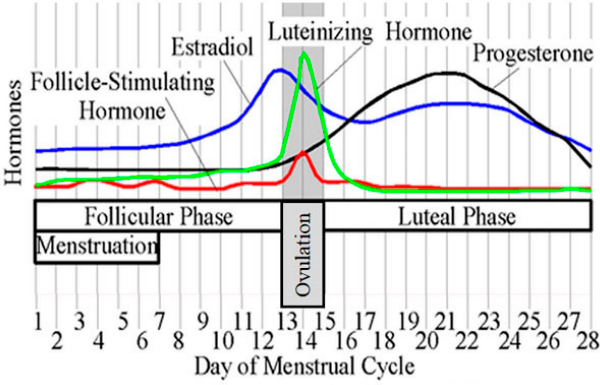
Figure 2. Menstrual cycle. Reprinted from https: // commons.wikimedia.org / wiki / File:MenstrualCycle2.